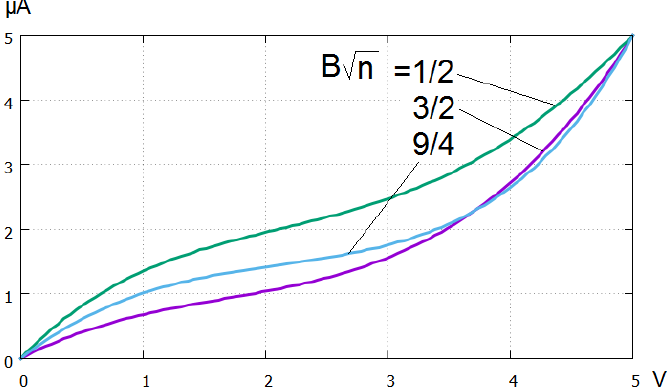
Figure 6. VAC of a semiconductor nanocomposite conglomerate .